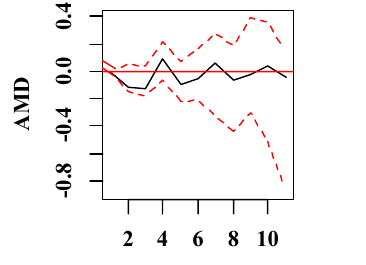
Fig. 9 Violin plot of AMD series in copula